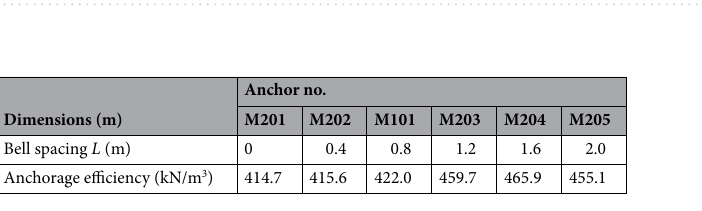
Table 6. Anchorage efficiency of group M2 anchors.